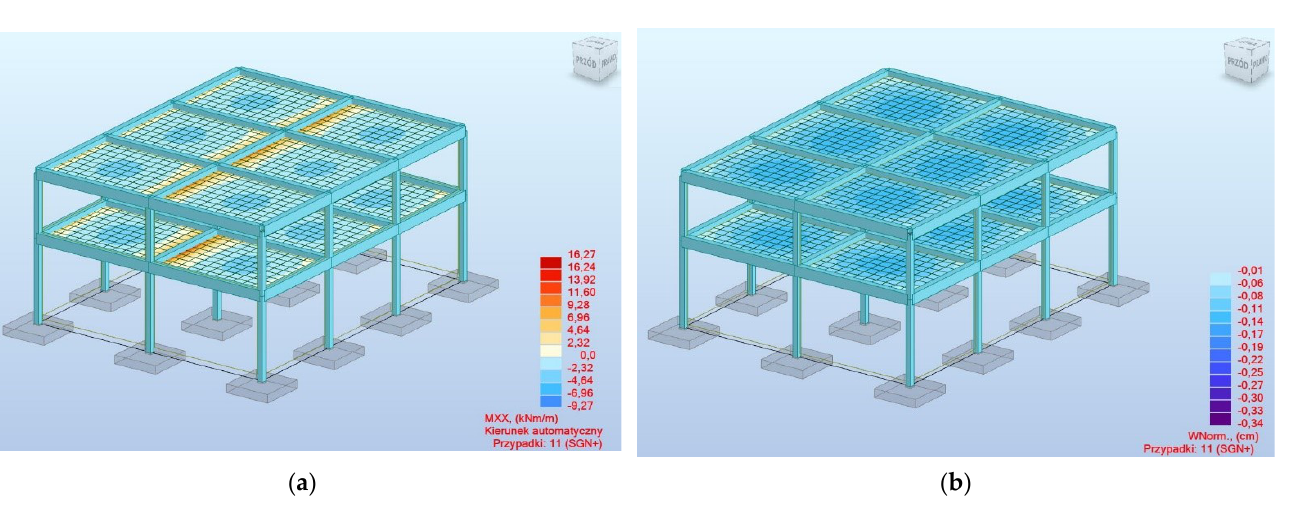
Figure 6. Examples of load combination effects: ( a ) map of flexural moments in the XX direction for floor slabs in ULS; ( b ) map of deflections of floor slabs in ULS.